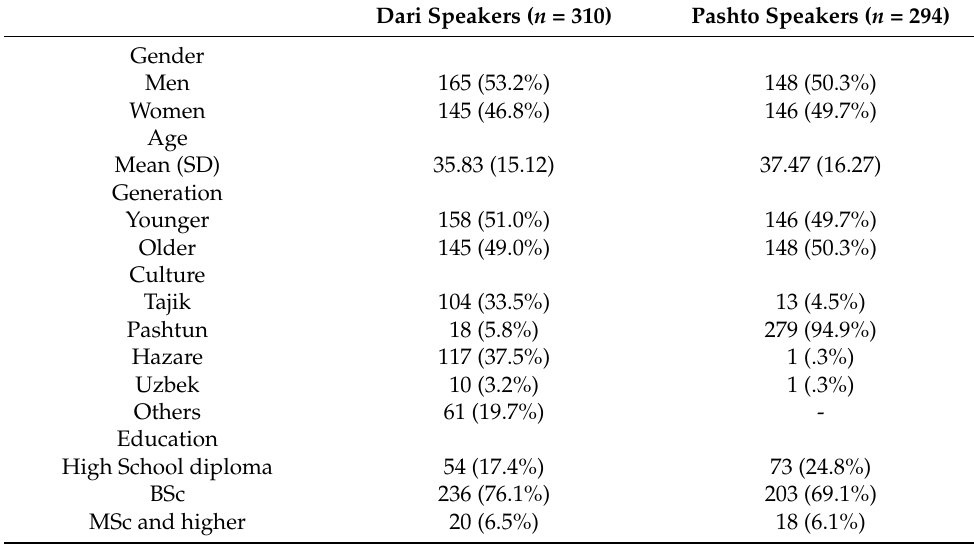
Table 1. The sample demographic